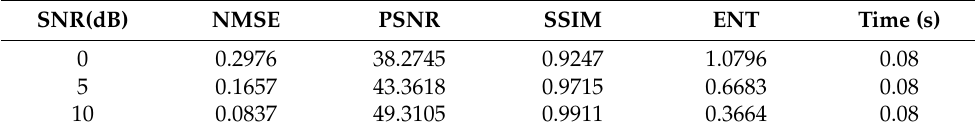
Figure 18. Images generated using 10% of available data with SNRs of ( a ) 0 dB, ( b ) 5 dB, and ( c ) 10 dB.